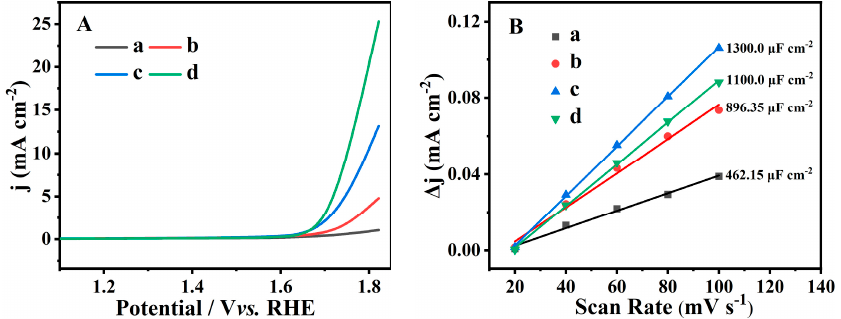
Figure 8. LSV curves ( A ) and plots of current density difference ( ∆ j) against the scan rate ( B ) of CP (a), Fe(0.03) − H(0.05) − CP − 3 (b), Fe(0.03) − H(0.05) − CP − 9 (c), and Fe(0.03) − H(0.00) − CP − 9 (d).